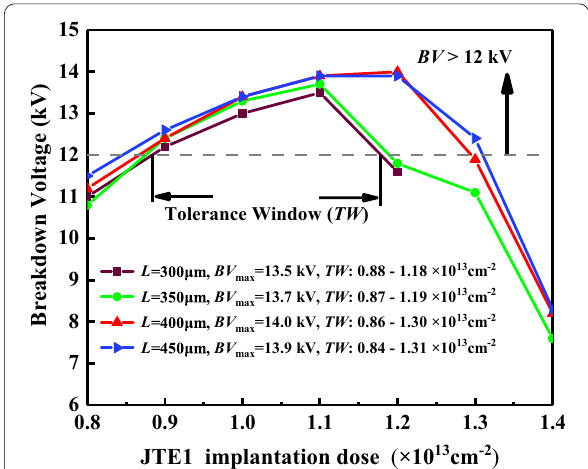
Fig. 5 Blocking capacities with different terminal